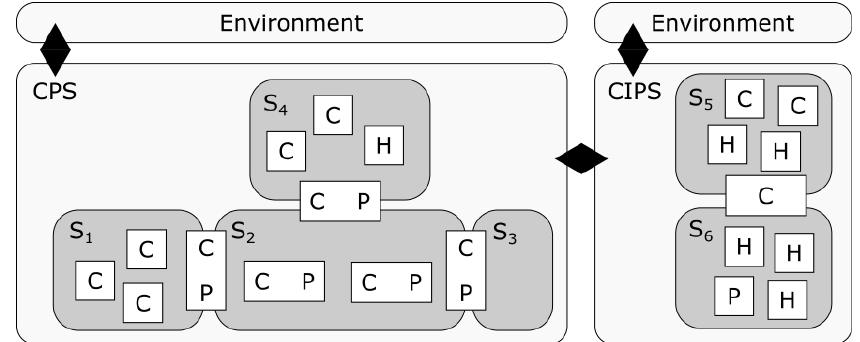
Figure 1. Conceptual view of a CPS with cyber (C), physical (P), and human (H) components arranged in multiple systems ( S i ) and a CIPS responsible for design, production, and